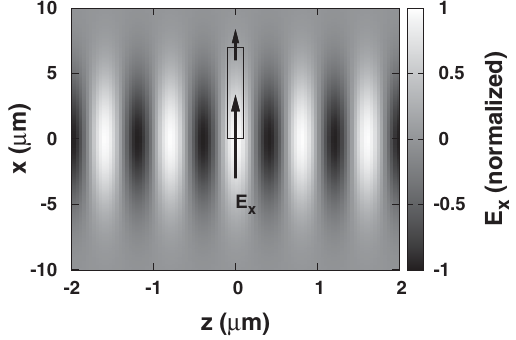
FIG. 3. Paraxial approximation of the tightly focused laser field. The field is polarized in the x direction, the beam waist is 5 (cid:1) m , and the wavelength is 800 nm. The rectangle in the graph indicates a thin and narrow box. The electric field (arrows) on the bottom of the box is stronger than the electric field on the top. Because the box does not include any charge, the paraxial approximation disagrees with Gauss’s